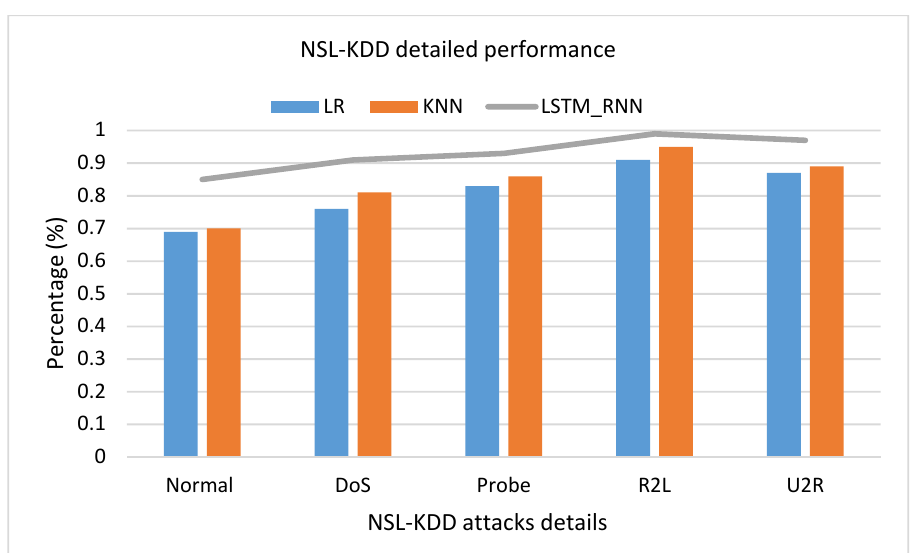
Figure 20. NSL-KDD detailed attacks classification accuracy comparison.